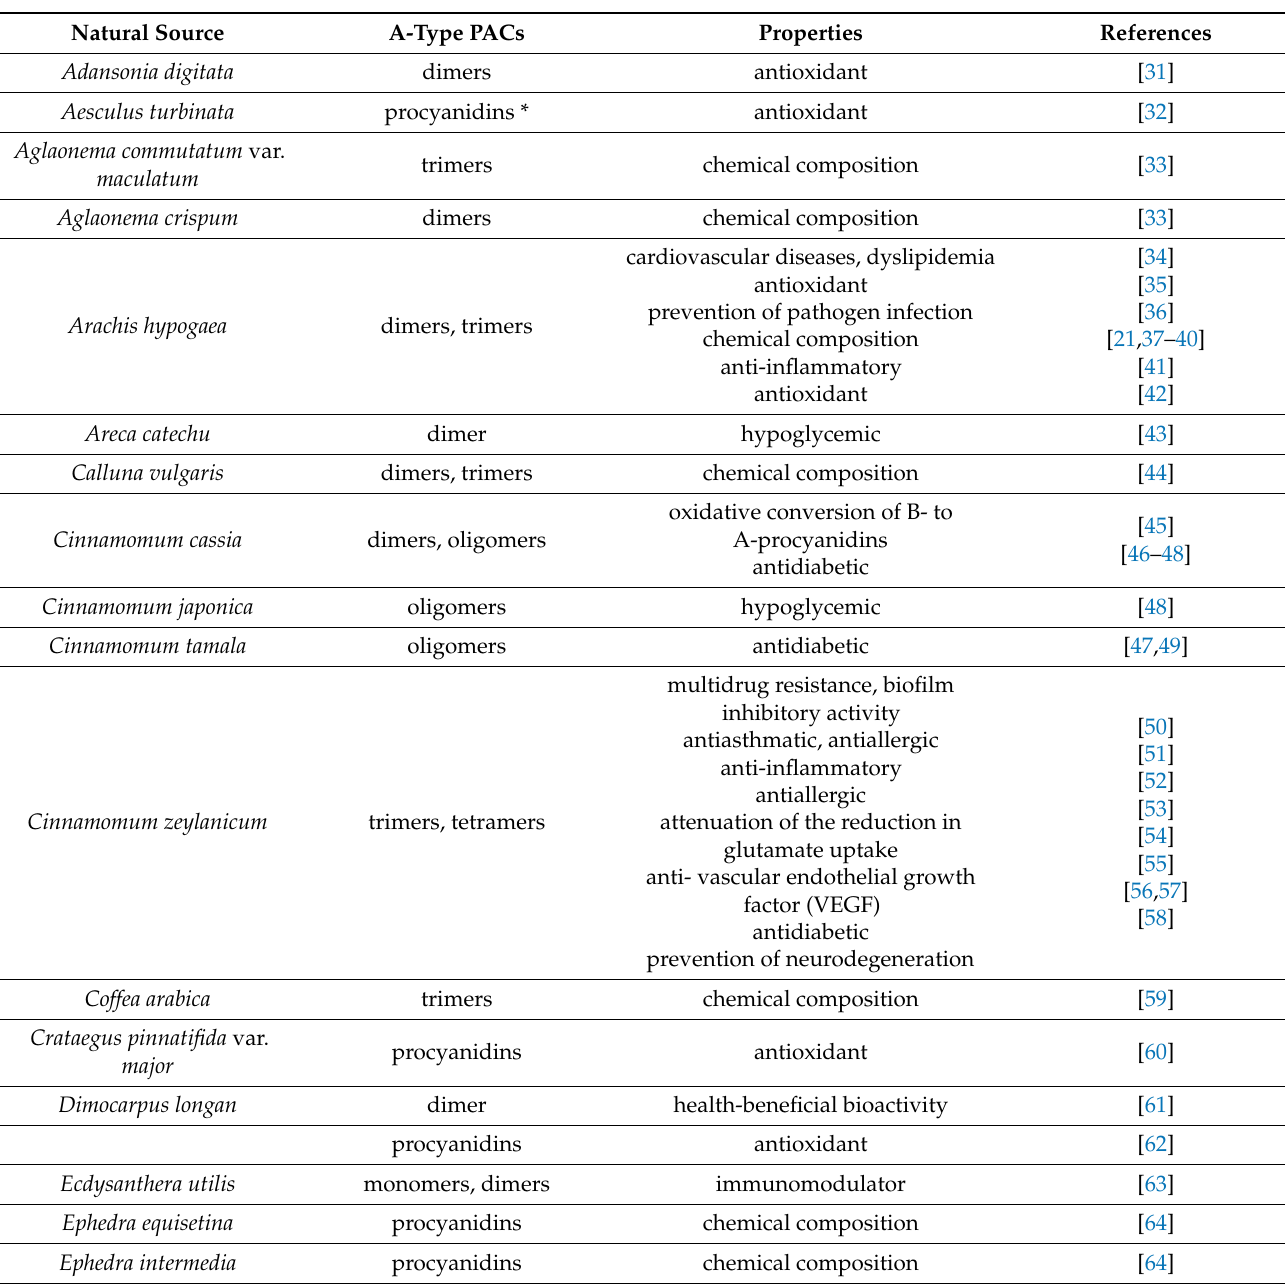
Table 1. Natural sources of A-type PACs and biological